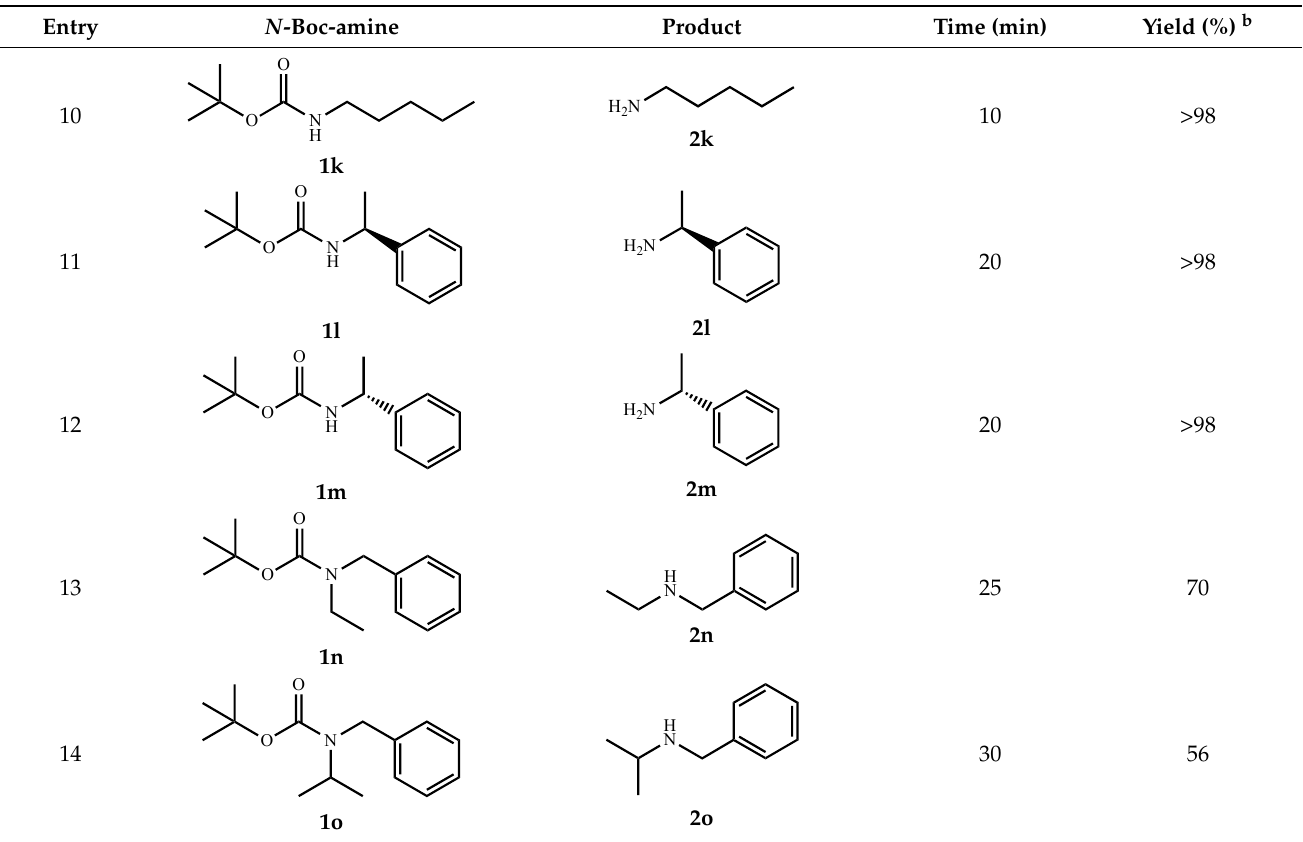
a Reaction conditions: all reactions were carried out by using 1 mmol of N -Boc amine in 1 mL of ChCl: pTSA at rt for the time reported above. b Isolated yields after work-up.